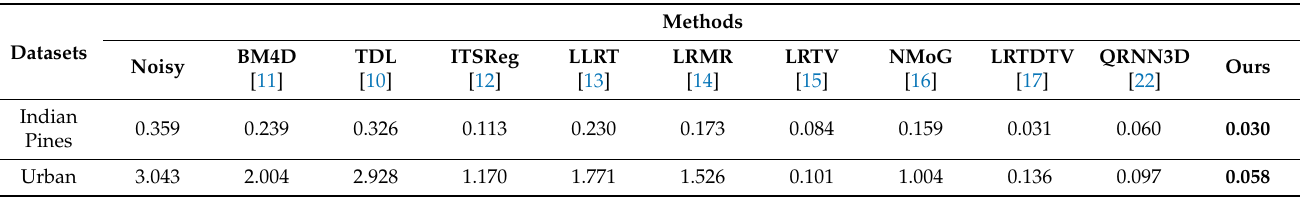
Table 6. Real HSI denoising results comparison using the no-reference quality